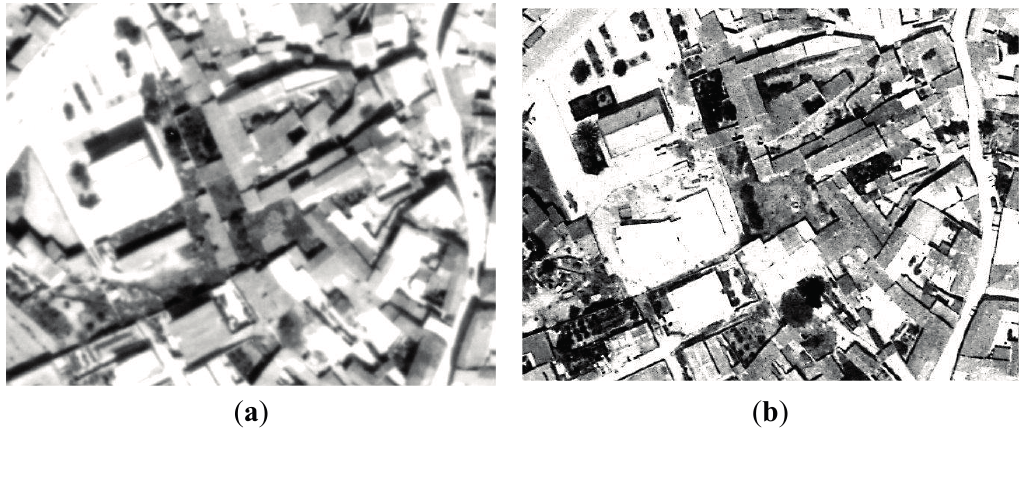
Figure 8. The historical aerial pictures of the test site. ( a ) 1977; ( b ) 1981; ( c ) 1987; ( d )